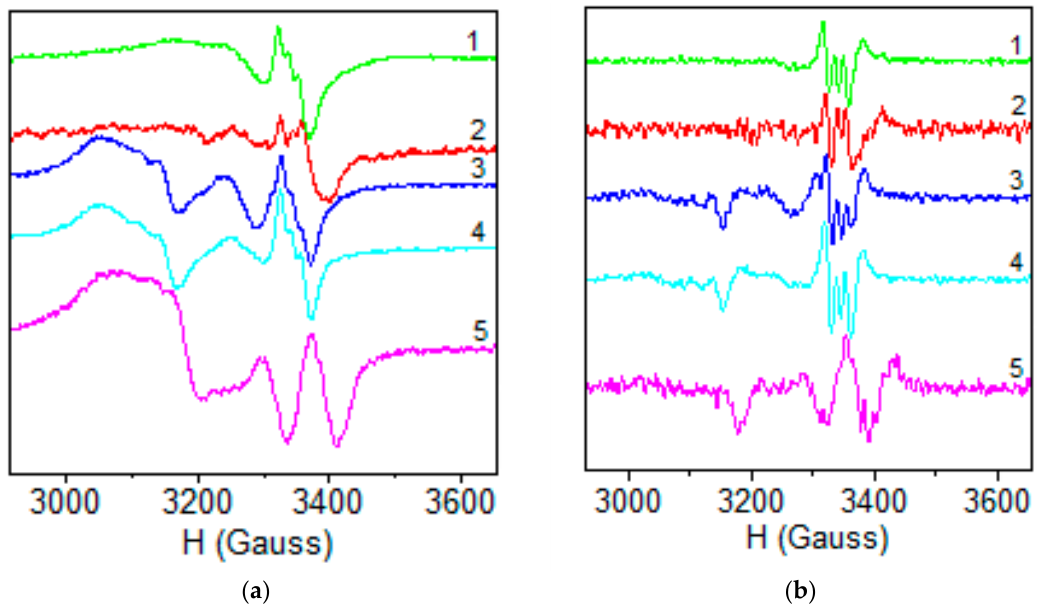
Figure 4. EPR spectra of complexes 1 – 5 in DMSO solution ( a ) at 298 K; ( b ) second derivative spectra.